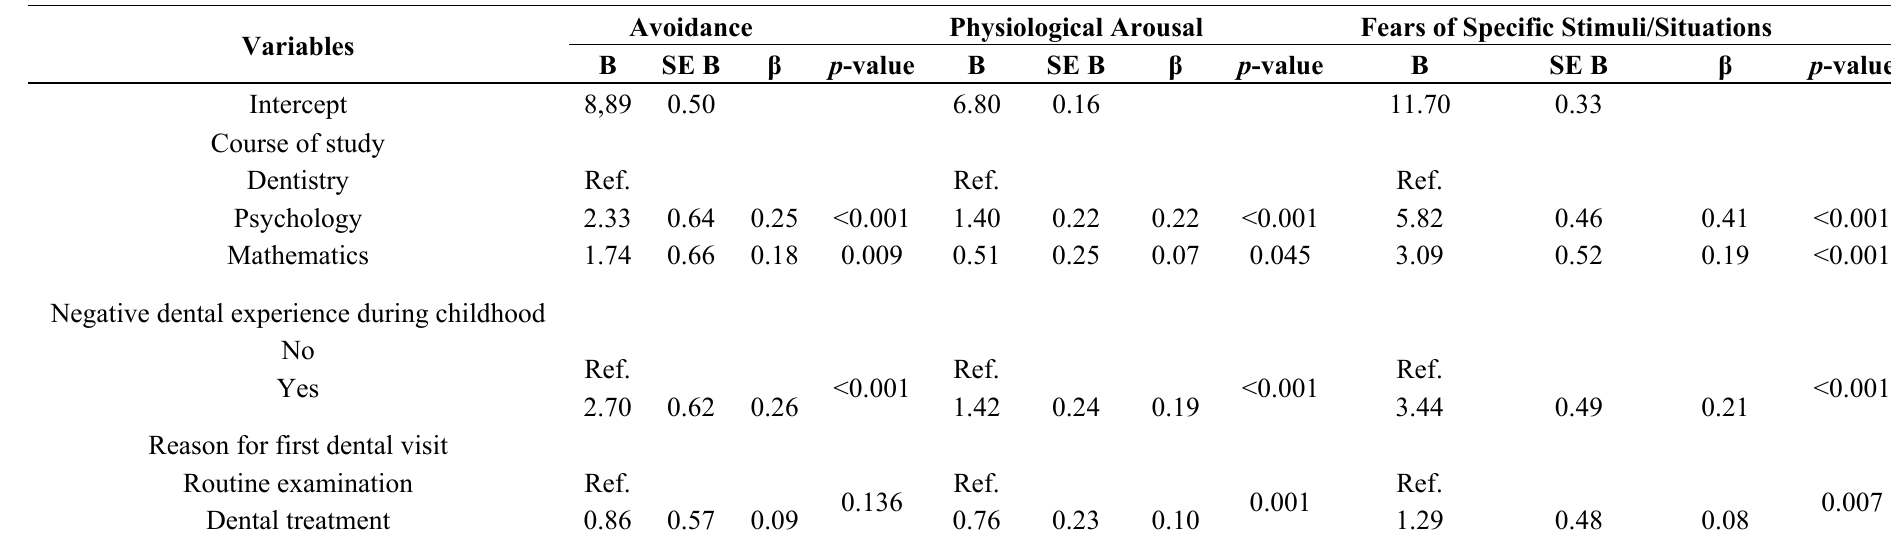
Table 3. Multivariate linear regression models for each dimension of DFS according to independent variables (n = 934). Avoidance Physiological Arousal Fears of Specific Variables